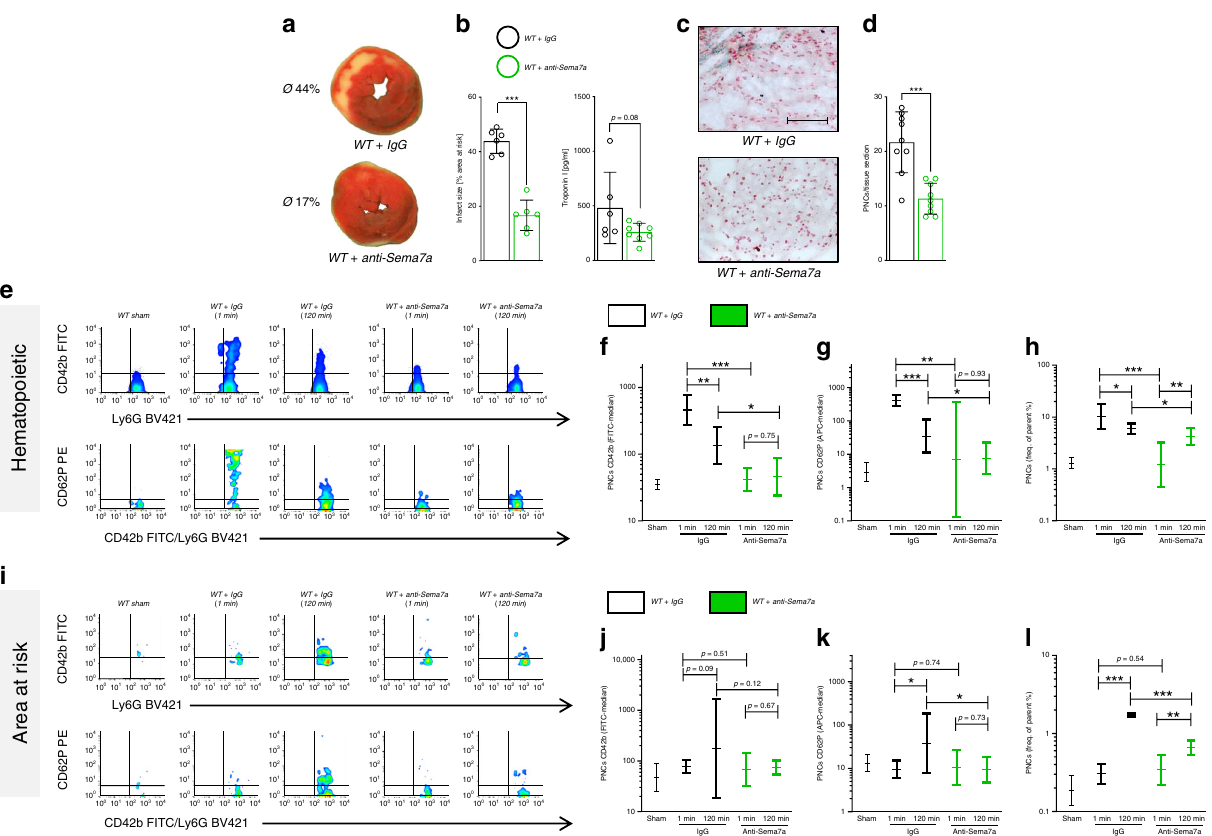
Fig. 6 Anti-Sema7a reduces MIRI, platelet activation and PNC formation. Animals were injected with either anti-semaphorin 7A antibody (anti-Sema7a) or IgG control 5 min before starting 120 min reperfusion after 60 min of ischemia, with samples taken after 1 or 120 min of reperfusion. a Representative TTC-stained heart slices of myocardial infarcts (blue/dark = retrograde Evans blue staining; red and white = AAR, white = infarcted tissue) with b systematic evaluation of infarct sizes ( n = 6/group) and correlating troponin I plasma levels ( n = 6;8). c Representative histology sections (scale bar 100 µ m) of WT animals injected with either IgG control or anti-Sema7a and d number of PNCs counted from myocardial tissue sections ( n = 9/group). e Representative fl ow cytometry plots of PNCs in the blood of Sham, anti-Sema7a-injected or IgG control-injected animals, expressing GPIb (CD42b) and P-selectin (CD62P). Systematic evaluation of fl ow-cytometric expression of mean fl uorescence intensity (MFI) for f GPIb (CD42b, n = 5;4;3;4;5) and g P-selectin (CD62P, n = 6;4;4;3;5) and h systematic evaluation of PNCs in % by fl ow cytometry in the blood of animals injected with anti-Sema7a or IgG control at 1 and 120 min ( n = 3;4;4;3;4). i Systematic evaluation of fl ow-cytometric expression of MFI for j GPIb (CD42b n = 4;5;3;3;4) k P-selectin (CD62P, n = 4/group) and l systematic evaluation of PNCs in % by fl ow cytometry in the AAR of animals injected with anti-Sema7a or IgG control at 1 and 120 min ( n = 5;6;5;4;4). Comparisons in b , d were analyzed by unpaired two-tailed Student ’ s t -tests (data are mean ± SD). For f – l we used log transformation of data to conform normality. For log-transformed data, unpaired two-tailed Student ’ s t -tests were performed on the log values and results are displayed as geometric means and their 95% con fi dence intervals. * p < 0.05, ** p < 0.01, and *** p < 0.001 as